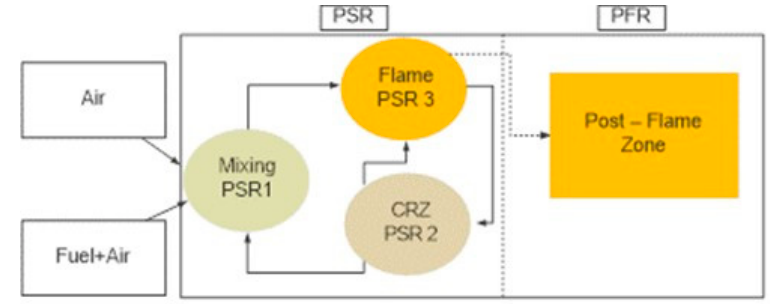
Figure 1. Chemical reaction network. Reprinted with permission, Elsevier, 2020 [5].